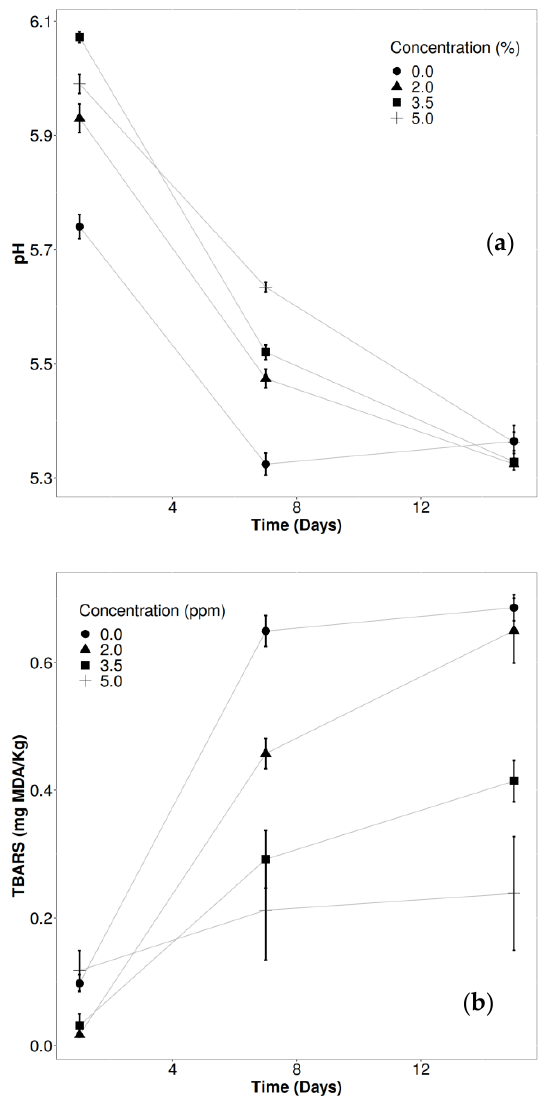
Figure 1. pH ( a ) and TBARS ( b ) of vacuum-packed ground beef containing different camu-camu powder levels stored at 5 °C.